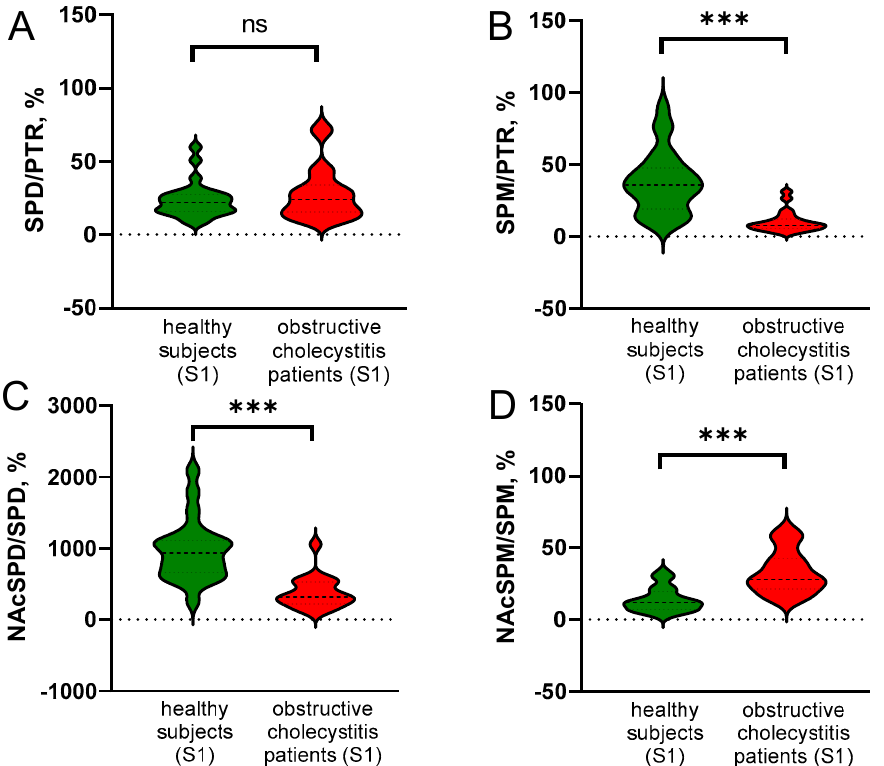
Figure 4. Estimated rate of production of PAs in healthy subjects and patients with cholecystitis. Approximate rates of conversion of ( A ) putrescine (PTR) to spermidine (SPD); ( B ) PTR to spermine (SPM); ( C ) SPD to N1Ac spermidine (NAcSPD); ( D ) SPM to N1Ac spermidine (NAcSPM). ***— p < 0.001; ns—not significant.